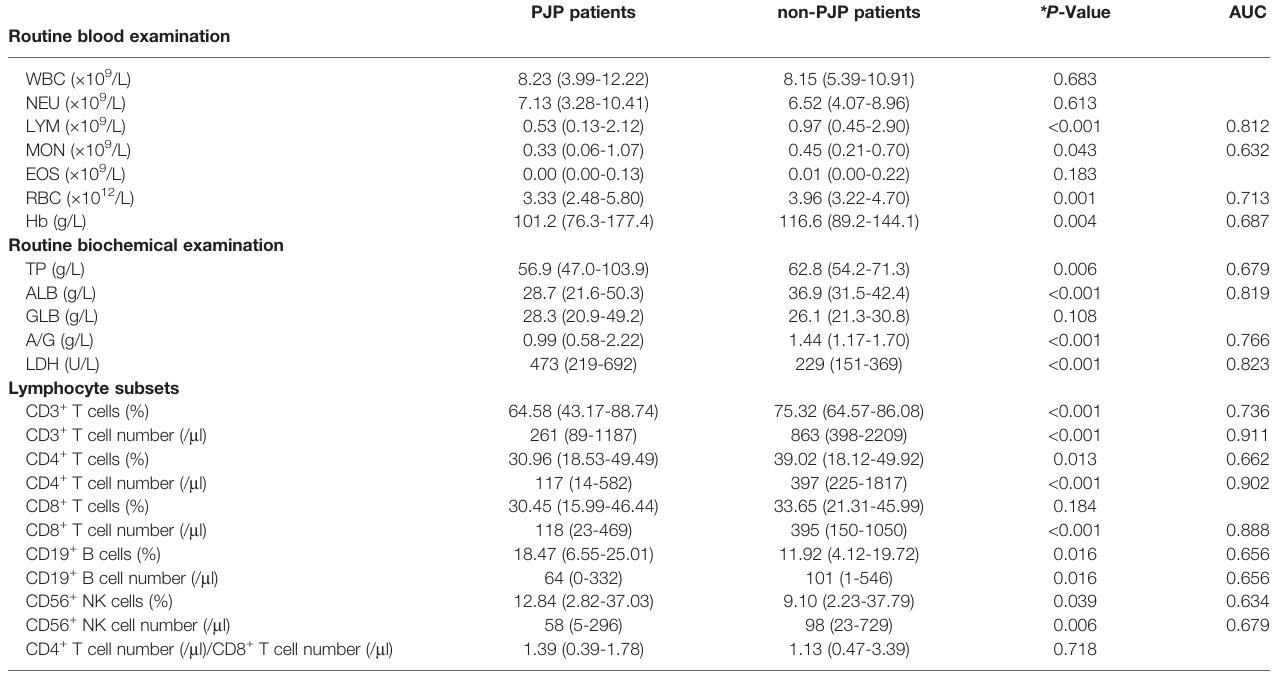
TABLE 2 | Routine laboratory fi ndings and immunological results of enrolled patients. PJP patients non-PJP patients *P